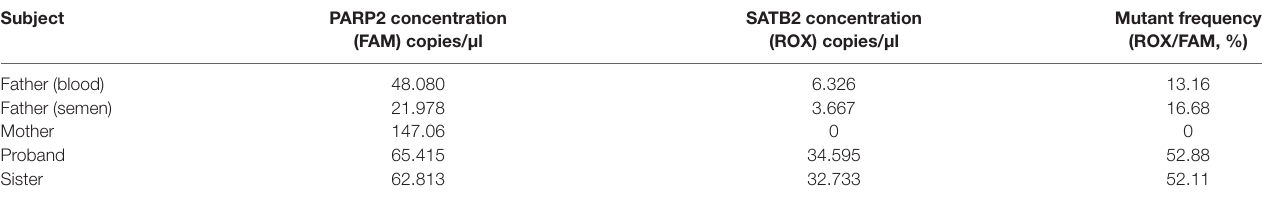
TABLE 3 | Mutant frequencies of SATB2 gene detected by Droplet Digital